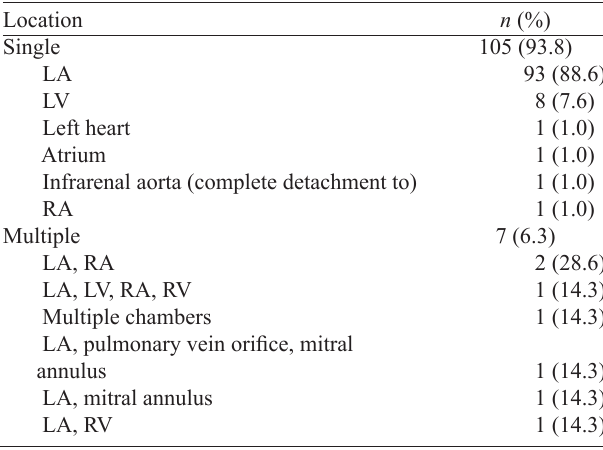
Table 10. Locations of 112 cardiac